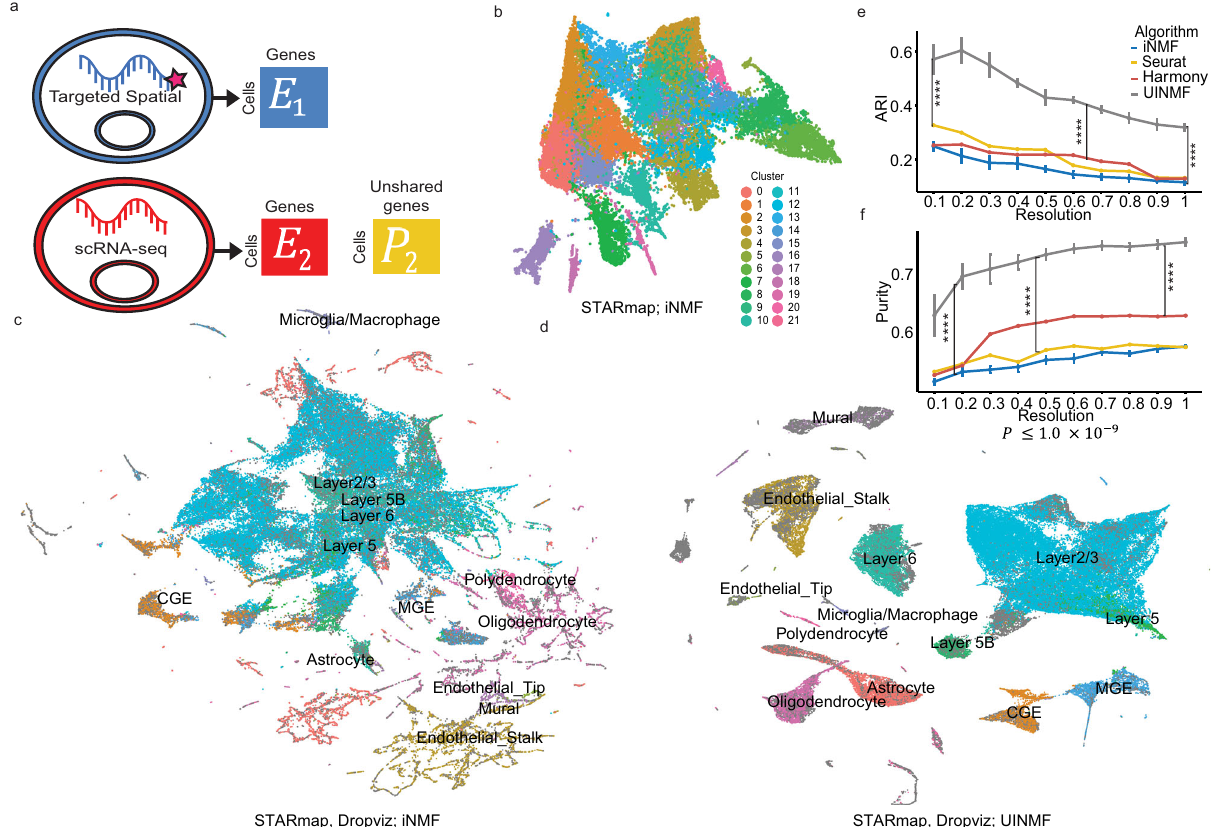
Fig. 3 Incorporating additional genes improves integration with STARmap data. a Schematic of UINMF integration of the spatial transcriptomic data with the scRNA-seq data, in which U incorporates unshared genes that are captured in scRNA-seq but not in the targeted STARmap data. b UMAP of STARmap data alone. c UMAP of STARmap and scRNA integration performed with iNMF using only shared genes. d UMAP of UINMF integration, which incorporates both shared and unshared genes. Both ( c ) and ( d ) are annotated using the original scRNA-seq labels and clusterings derived from either the iNMF ( c ) or UINMF ( d ) algorithm. We compared the adjusted rand index ( e ) and purity ( f ) metrics from UINMF with iNMF ( P = 3.895 × 10 − 10 , P = 3.895 × 10 − 10 ), Seurat v3 ( P = 3.895 × 10 − 10 , P = 3.895 × 10 − 10 ), and Harmony ( P = 3.895 × 10 − 10 , P = 3.895 × 10 − 10 ) for a range of clustering resolutions, using a paired, one-sided Wilcoxon test ( n = 100 values for each test, with each sample having fi ve values across 10 resolutions). For nondeterministic algorithms, data are presented as mean values + / −